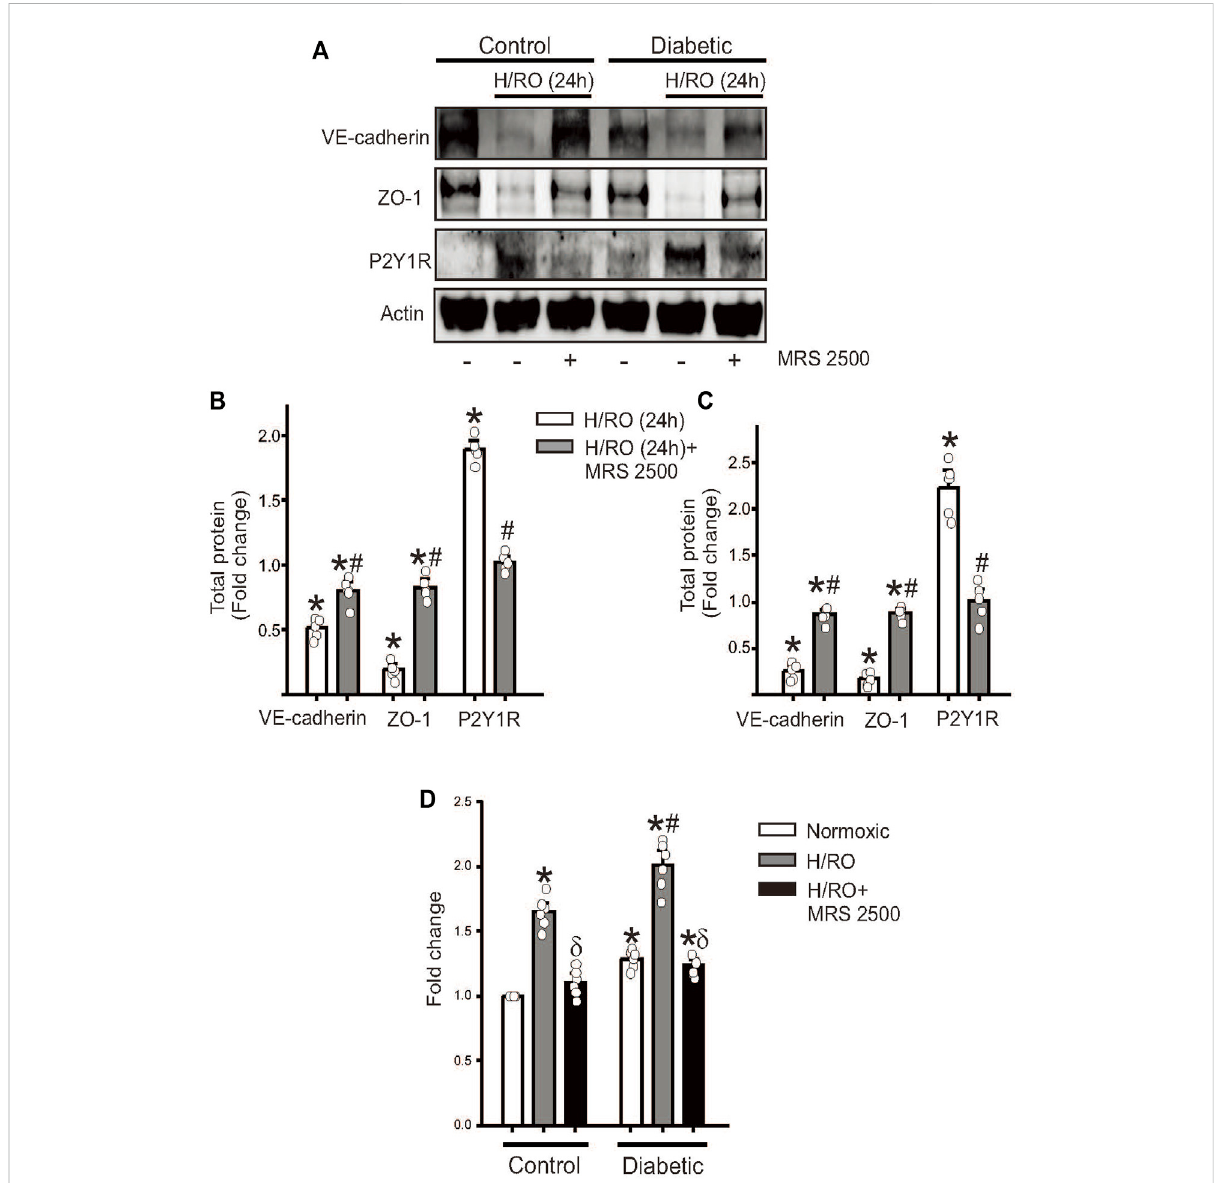
FIGURE 3 P2Y1R antagonist, MRS 2500, rescues endothelial function after H/RO. Representative Western blots showing the expression of VE-cadherin, ZO-1, P2Y1 receptor and actin in (A) , control and diabetic endothelial cells with or without H/RO and MRS 2500 treatment. Bar graphs for protein expression in control, (B) , and diabetic cells, (C) , presented as fold change in total protein and mean ± SE. n = 5 for each, * indicates p < 0.05 vs. untreated control, # indicates p < 0.05 vs. respective H/RO (24 h) treatment. (D) . Bar graph showing fold change in endothelial transwell permeabilityinnormoxic,afterH/RO(24 h)aloneandH/RO(24 h)+MRS2500treatedcells. n =6foreach.*indicates p < 0.05vs.normoxiccontrol, # indicates p < 0.05 vs. normoxic diabetic and δ indicates p < 0.05 vs. respective H/RO (24